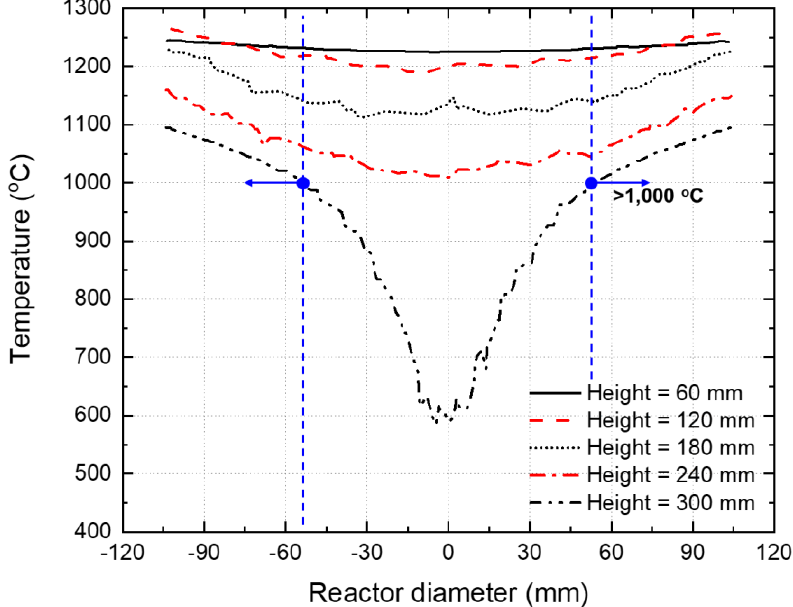
Figure 22. Temperature distribution by height in the reactor (full cavity).